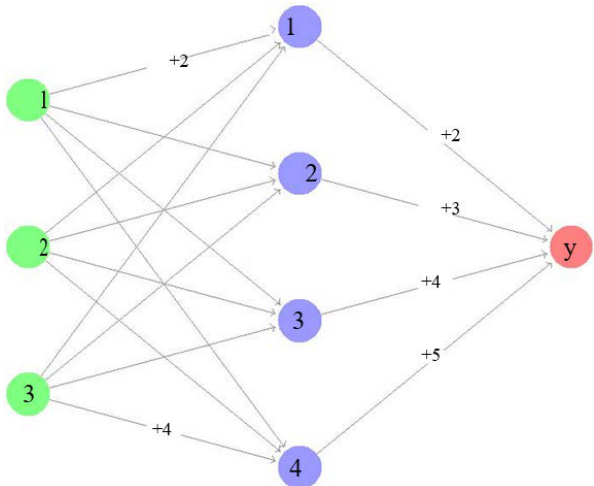
Fig. 1 Structure of a three-layer neural